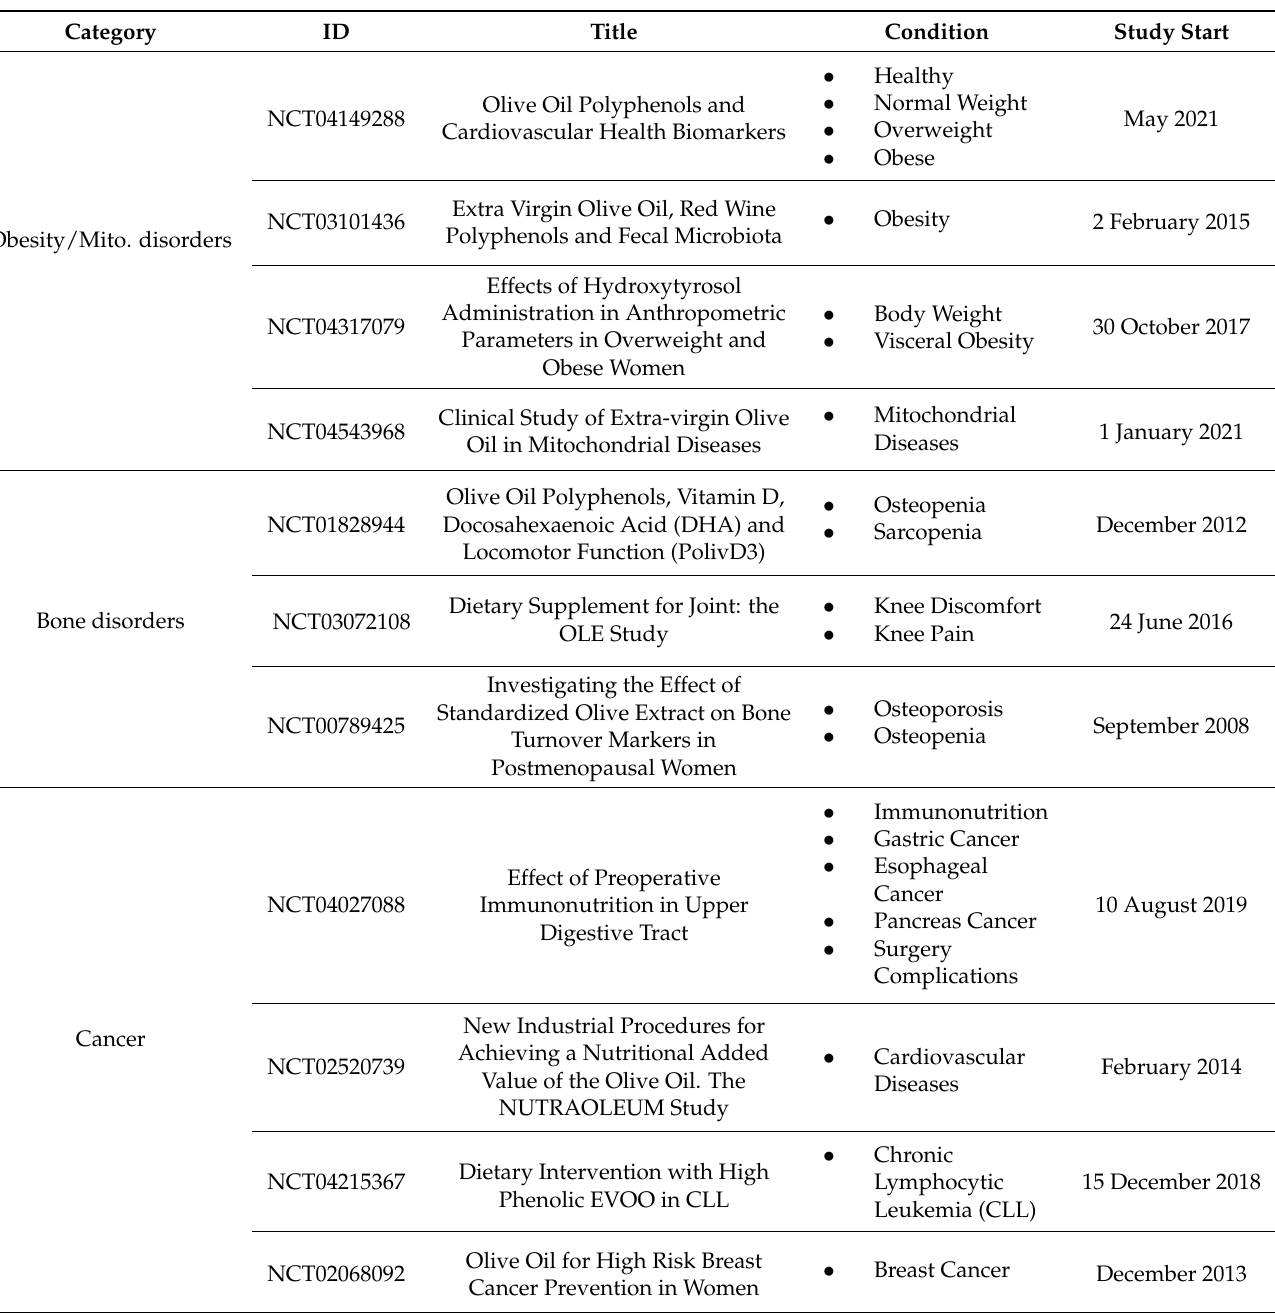
Table 1. Main characteristics of the 37 studies considered in this